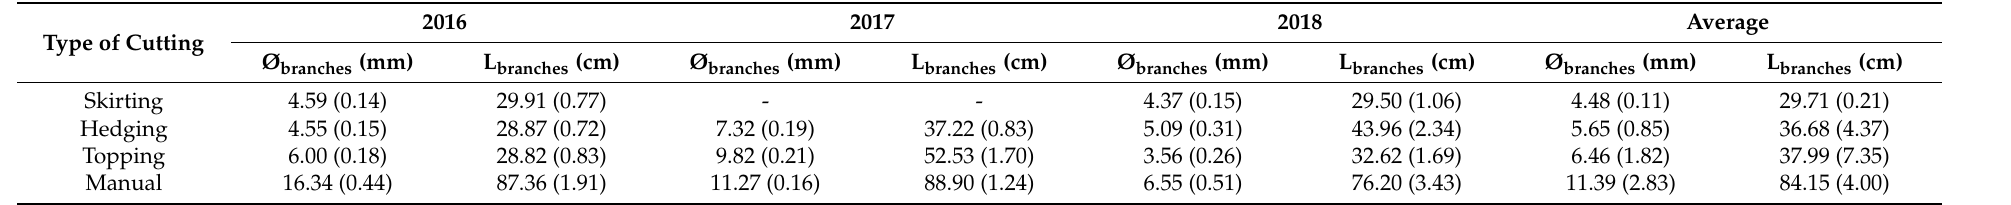
Table 5. Mean (standard error) diameter of the cutting area (Ø) and the length (L) of cut branches by the type of